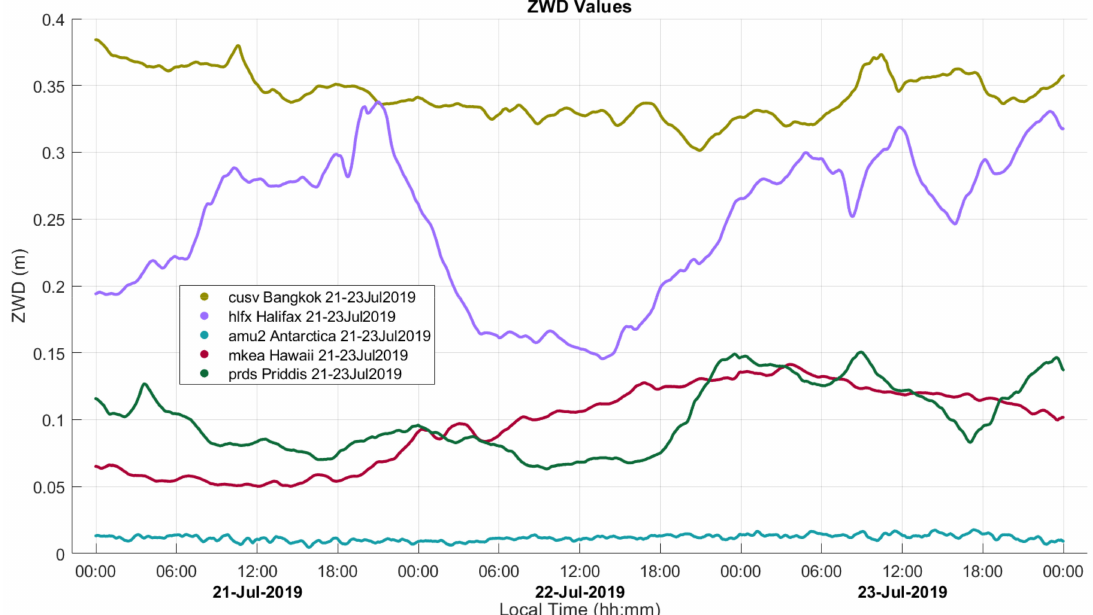
Figure 1. ZWD variability at five IGS stations. Sea-level heights are approximately 100 m (Bangkok), 25 m (Halifax), 2845 m (Antarctica), 3725 (Hawaii), and 1265 m